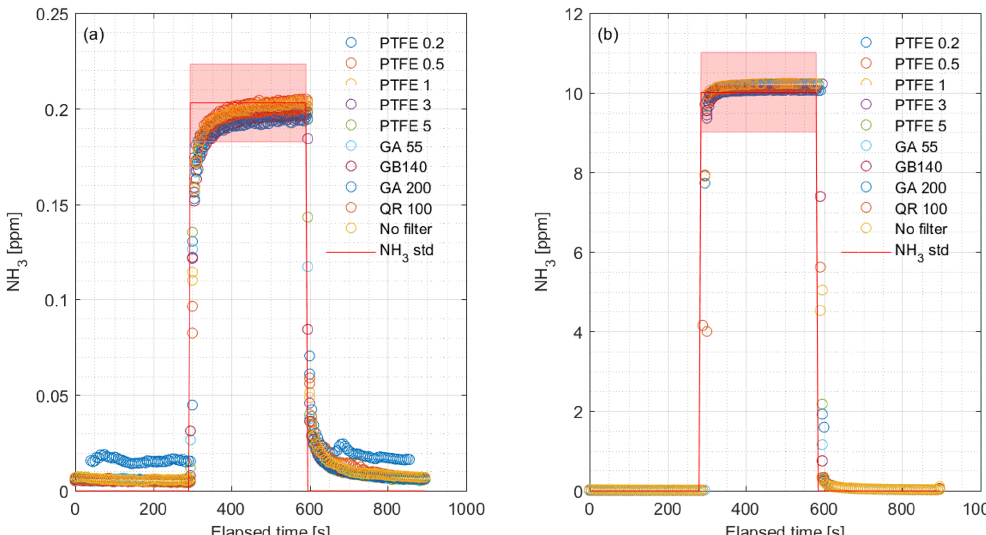
Figure 4. The response to a step change in NH 3 at (a) 0.203 and (b) 10.01ppm with and without external inlet filters during laboratory testing. The red line and area represent the NH 3 standard gas concentration with 10% accuracy. See the legend abbreviations in Table